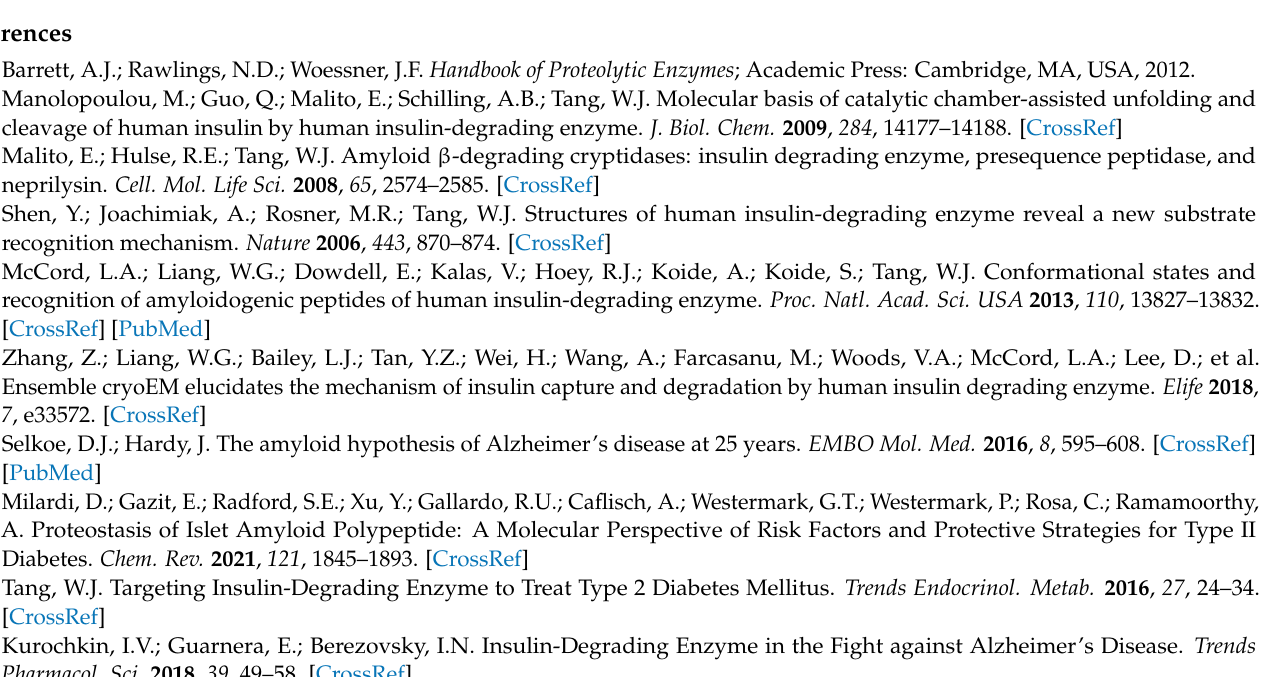
S4: Kinetics of IDE-dependent degradation of insulin in the absence and presence of EGCG at 37 ◦ C, Table S1: Steady-state kinetic parameters of the IDE-dependent proteolysis of insulin determined from Lineweaver–Burk plots, Table S2: Steady-state kinetic parameters of IDE-dependent proteolysis of insulin determined from Hanes–Woolf